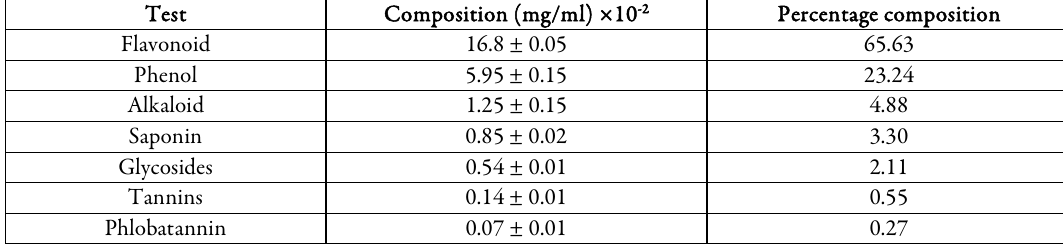
Figure 2. Thin layer chromatogram of ethyl acetate-ethanolicextract fraction of Carica papaya leaves (A) and the standard flavonoid; quercetin (B) Table 1. Phytochemical constituents of ethyl acetate-ethanolic fraction of Carica papaya